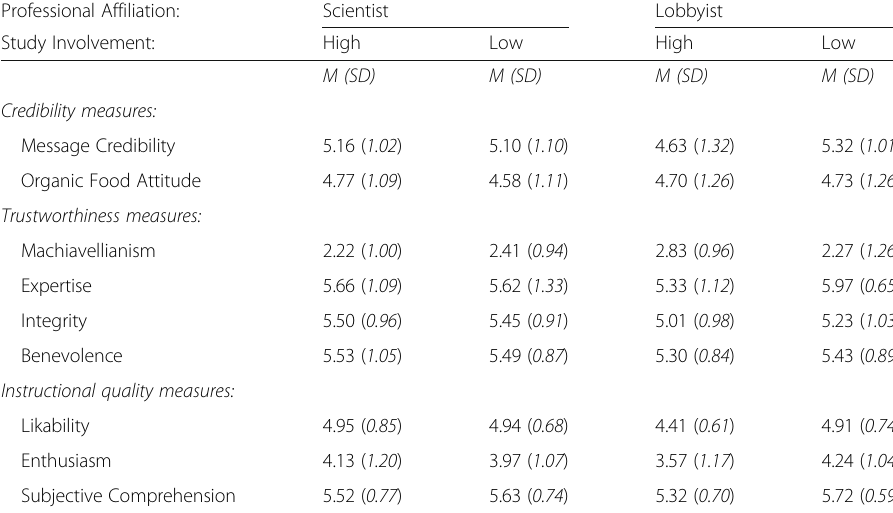
Table 2 Means and standard deviations of the dependent